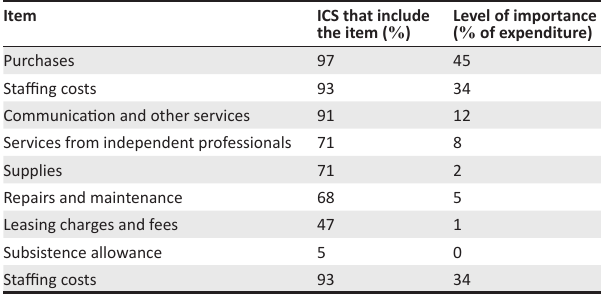
TABLE 3: Use and importance of inputs.